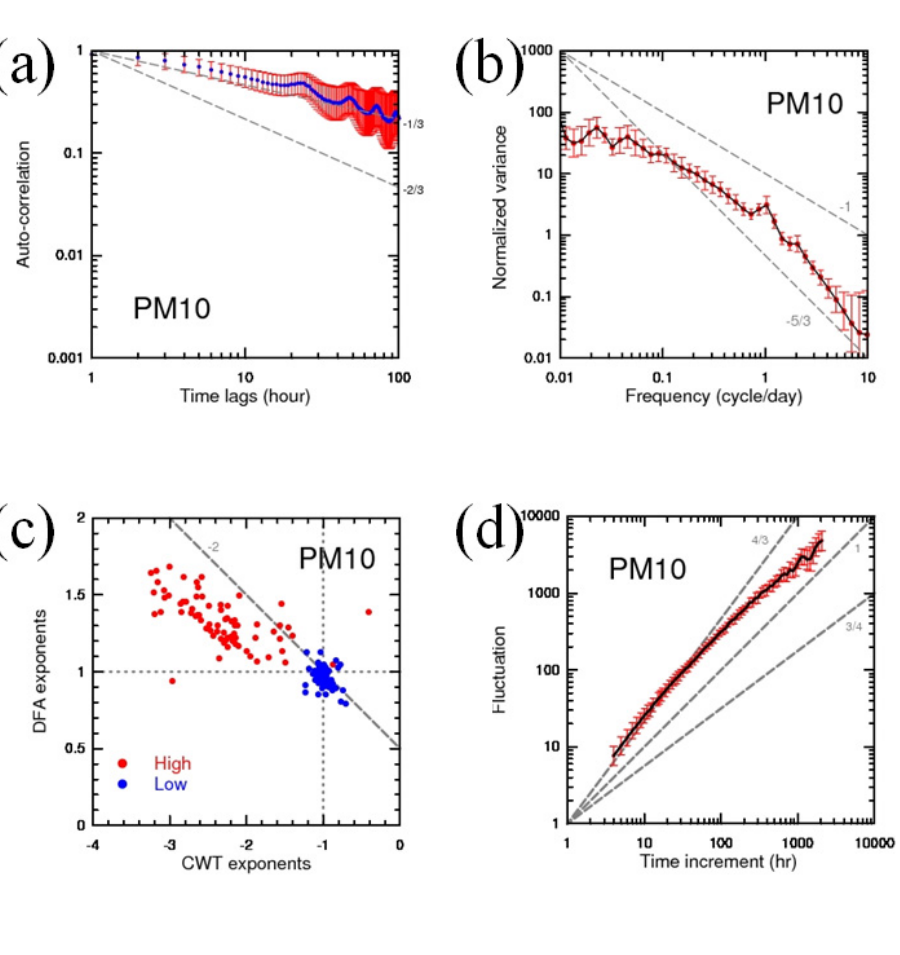
Fig. 12. For aerosol (PM 10 ) . Panel (a) : auto-correlation. Panel (b) : CWT spectrum. Panel (d) : DFA spectrum. Panel (c) : the scatter plot of the CWT and DFA spectral exponents.